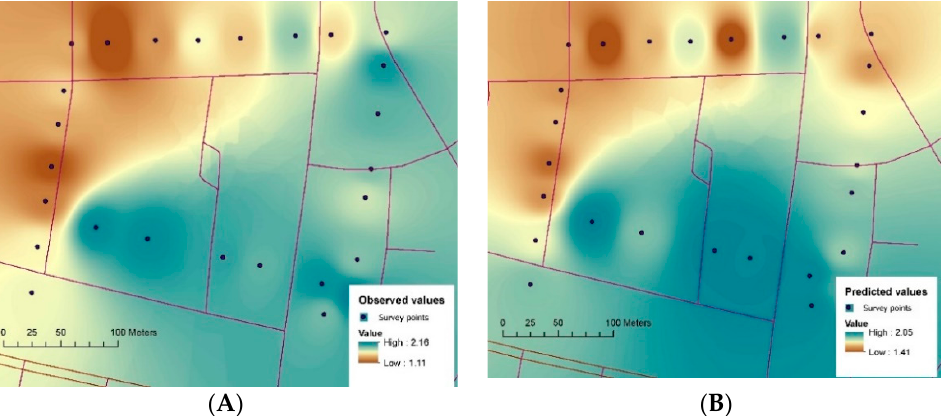
Figure 3. Observed ( A ) vs. predicted ( B ) values of PLQI in the study neighborhood (Note: The predictions are based on Model 3 (Table 2), applied to individual pixels of the neighborhood map (see Figure 3).